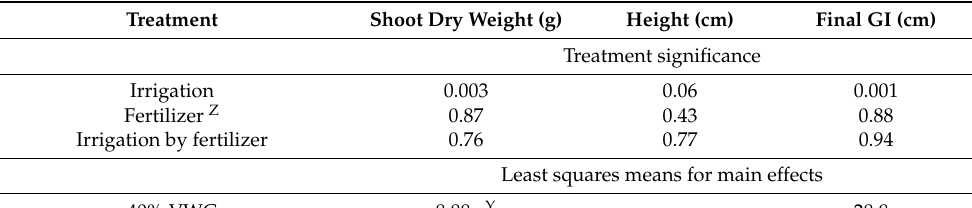
Table 1. Shoot dry weight, height, and growth index of ‘Visions’ astilbe in response to substrate volumetric water content (VWC) and fertilizer rate treatments at the conclusion of the 61d experiment. The 40% VWC treatment was considered well-watered while the 18% treatment supplied a reduced irrigation treatment. Shoots were cut off at the substrate surface and were dried at 50 ◦ C for 1 week after which dry weight was determined. Growth index (GI) was calculated as follows: (height + width 1 + width 2/3).